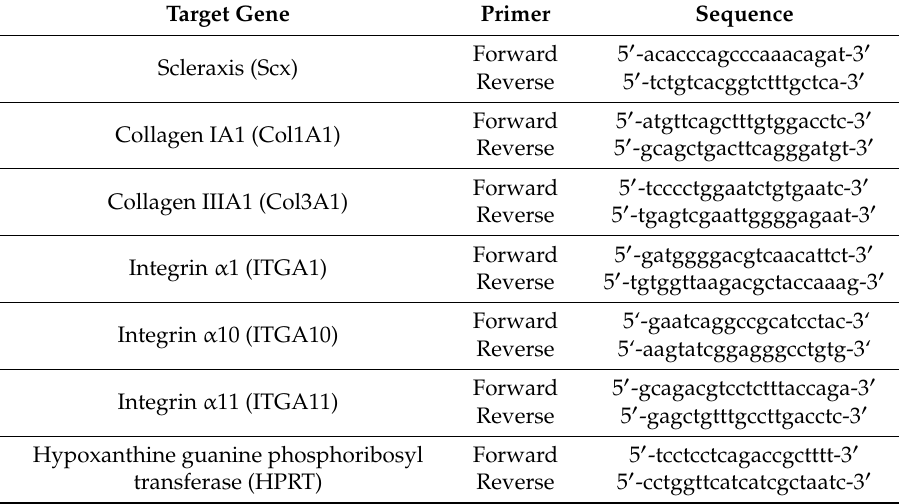
Table 1. Sequence of the primers used in quantitative real-time